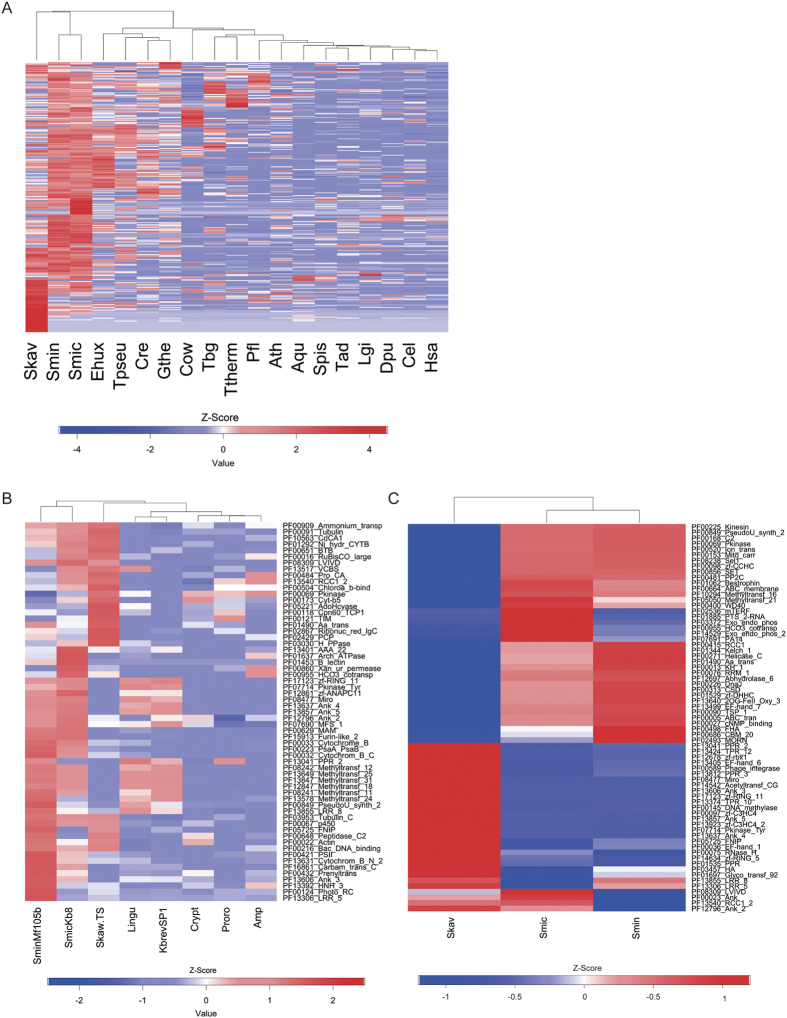
Pfam domain enrichment in protein sets of Symbiodinium microadriaticum, Symbiodinium minutum, and Symbiodinium kawagutii (A) in comparison to 16 reference eukaryotic genomes, (B) in comparison to other dinoflagellate transcriptomes, (C) among Symbiodinium genomes. Rows indicate distinct Pfam domains. Domain enrichment was estimated via Fisher’s exact test on domain ratios, colors represent z-scores, and samples were clustered by Euclidean distance. Species names providing reference genomes are abbreviated as per the following: Symbiodinium kawagutii (Skav), Symbiodinium minutum (Smin), Symbiodinium microadriaticum (Smic), Emiliania huxleyi (Ehux), Thalassiosira pseudonana (Tpseu), Chlamydomonas reinhardtii (Cre), Guillardia theta (Gthe), Capsaspora owczarzaki (Cow), Trypanosoma brucei gambiense (Tgb), Tetrahymena thermophila (Ttherm), Plasmodium falciparum (Pfl), Arabidopsis thaliana (Ath), Amphimedon queenslandica (Aqu), Stylophora pistillata (Spis), Trichoplax adhaerens (Tad), Lottia gigantea (Lgi), Daphnia pulex (Dpu), Caenorhabditis elegans (Cel), Homo sapiens (Hsa). Species names providing reference transcriptomes are abbreviated as per the following: Symbiodinium microadriaticum strain Kb8 (SmicKb8), Symbiodinium minutum strain Mf1.05b (SminMf1.05b), Symbiodinium kawagutii (Skaw.TS), Karenia brevis strain SP1 (KbrevSP1), Lingulodinium polyedrum (Lingu), Prorocentrum minimum (Proro), Amphidinium carterae (Amp), and Crypthecodinium cohnii (Crypt). A complete list of pfam domains and pfam annotations for all analyses are accessible in the supplement (Dataset S1.2, Dataset S1.3, Dataset S.14, Supplemental Information, Table S5).